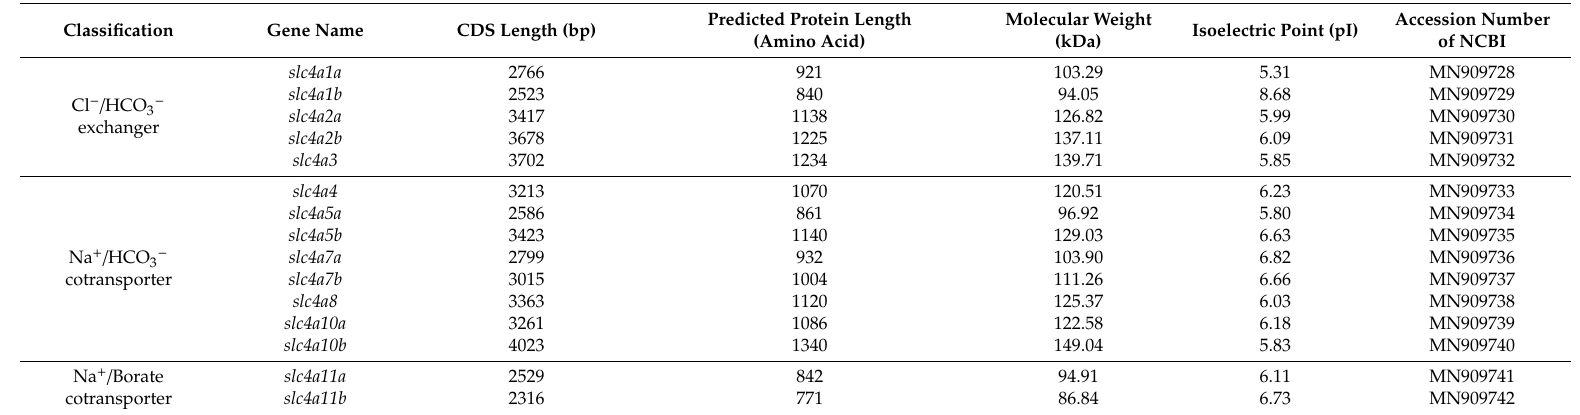
Table 1. Summary of characteristics of slc4 genes in spotted sea